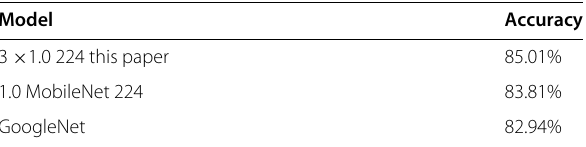
Table 5 Compare this paper network with popular networks in Tiny ImageNet dataset